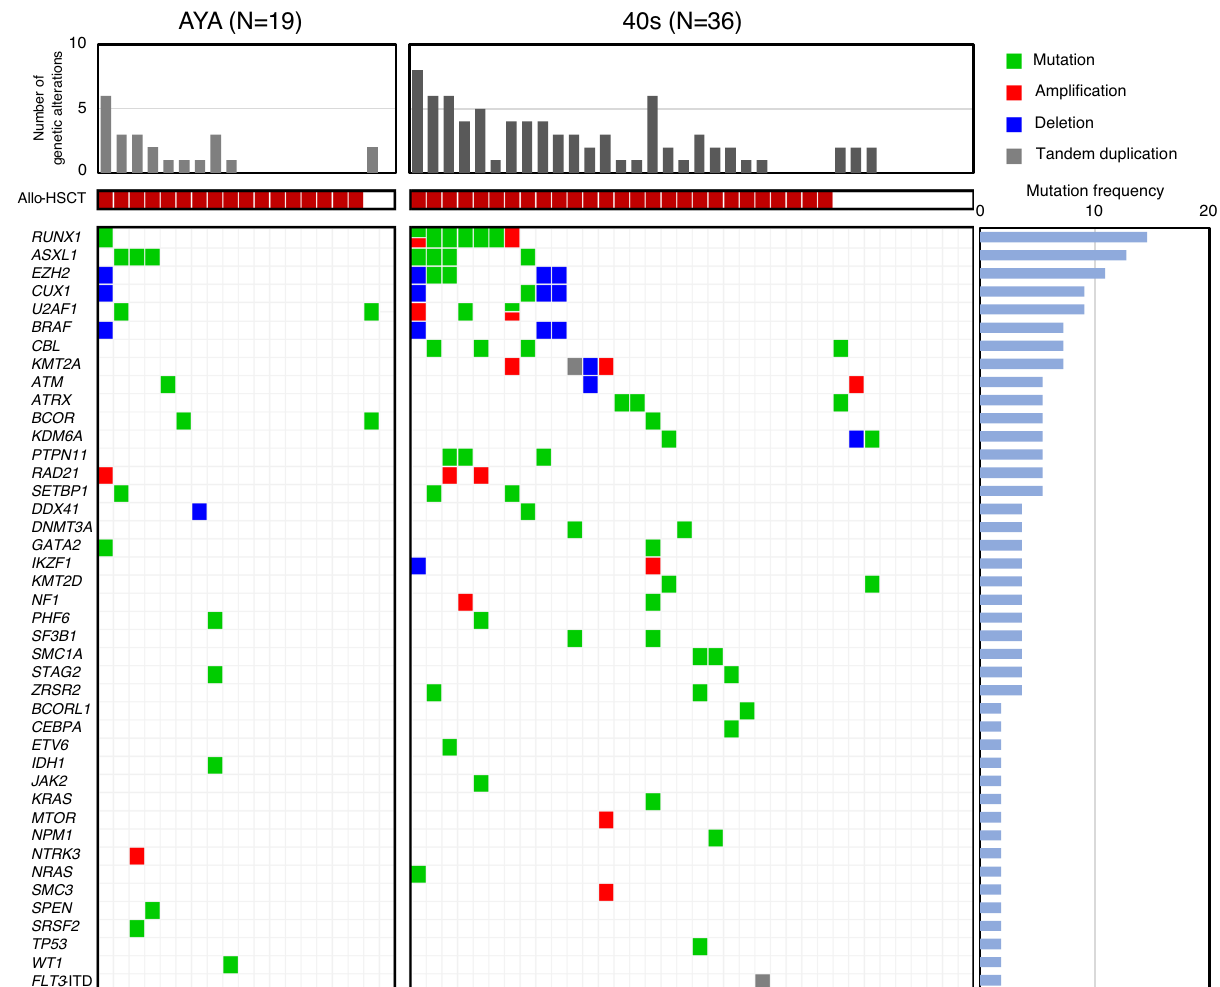
Figure 1. The number of genetic alterations in all 55 patients with targeted sequencing. The total number of genetic alterations in individual cases (top) in the AYA generation and in patients in their 40s, whether or not they had undergone HSCT during the clinical course (middle), and the profiles of each gene (bottom). AYA, adolescents, and young